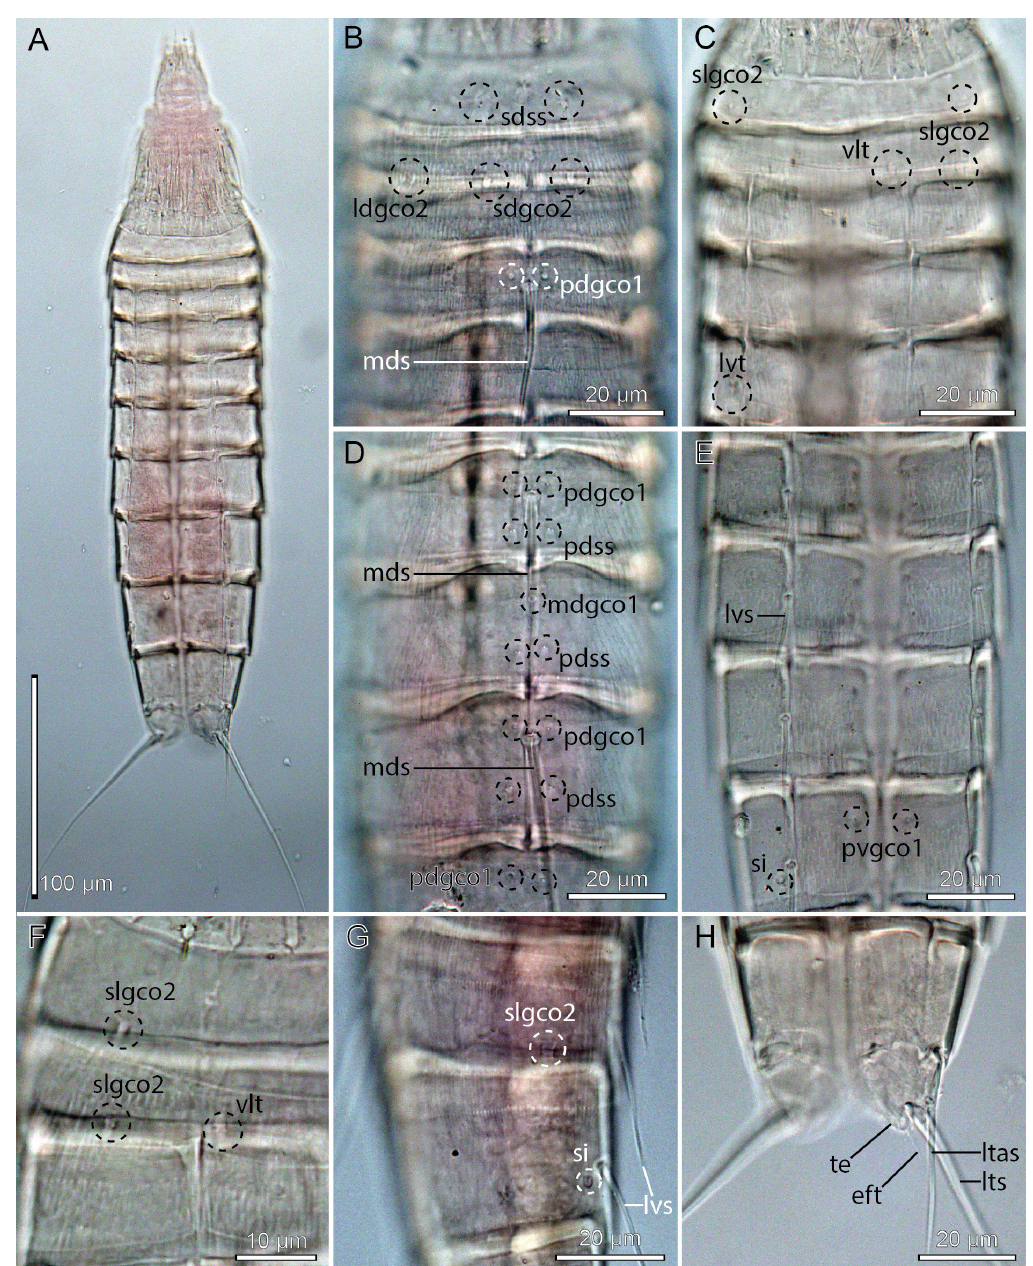
Fig. 8. Light micrographs showing overviews and details of Echinoderes hamiltonorum sp. nov., holotype, ♀ (A–D, H) (NHMD-223916), paratype, ♂ (E–F) (NHMD-223918) and paratype, ♀ (G) (NHMD-223920). A . Ventral overview. B . Segments 1 to 5, dorsal view. C . Segments 1 to 5, ventral view. D . Segments 6 to 8, dorsal view. E . Segments 6 to 9, ventral view. F . Detail showing sublateral glandular cell outlets type 2 on segments 1 and 2. G . Segments 8 to 9, lateral view. H . Segments 10 to 11 in female, ventral view. Abbreviations: eft = extended fringe tips; ldgco2 = laterodorsal glandular cell outlet type 2; ltas = lateral terminal accessory spine; lts = lateral terminal spine; lvs = lateroventral spine; lvt = lateroventral tube; mdgco1 = middorsal glandular cell outlet type 1; mds = middorsal spine; pdgco1 = paradorsal glandular cell outlet type 1; pdss = paradorsal sensory spot; pvgco1 = paraventral glandular cell outlet type 1; sdgco2 = subdorsal glandular cell outlet type 2; sdss = subdorsal sensory spot; si = sieve plate; slgco2 = sublateral glandular cell outlet type 2; te = tergal extensions; vlt = ventrolateral